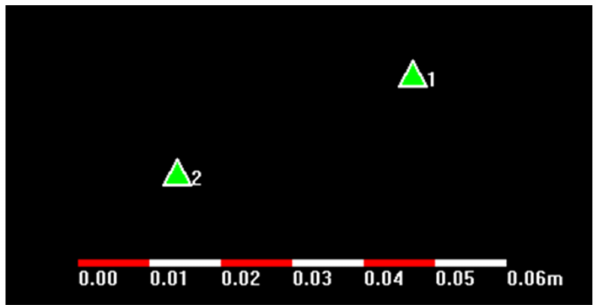
Figure 7. Relative position of two coordinates.